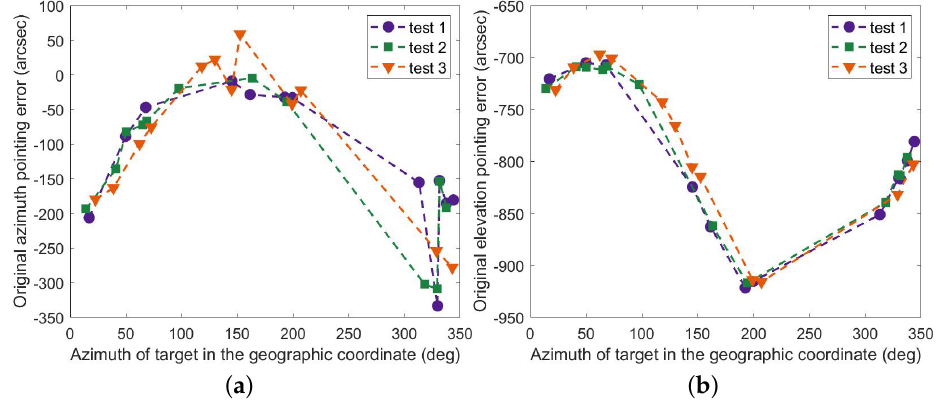
Figure 11. Original pointing error of the EOT ( a ) in azimuth and ( b ) in